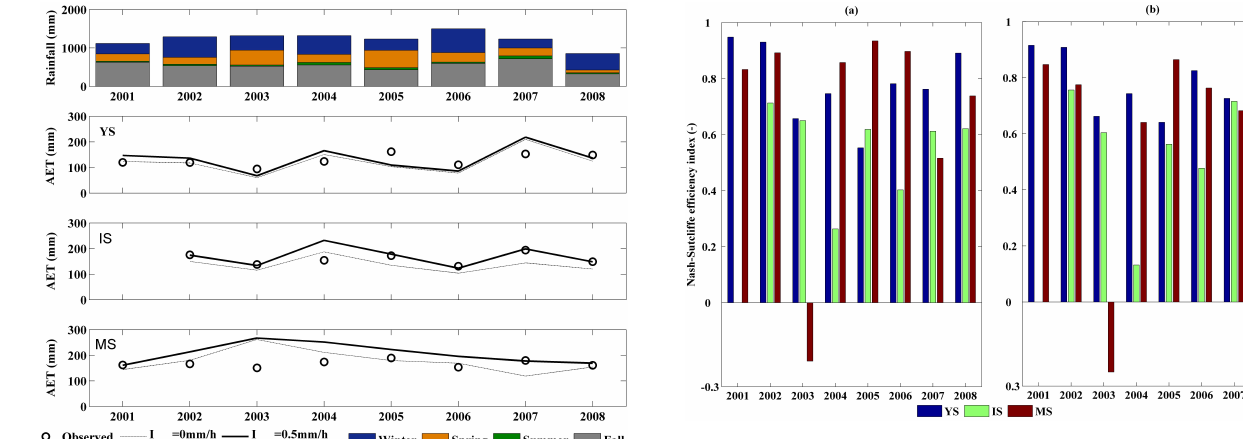
Fig. 4. Inter-annual variability of seasonal precipitation (top) and, observed and modeled summer AET at the different successional forest stands. AET modeled with 1t =30min.